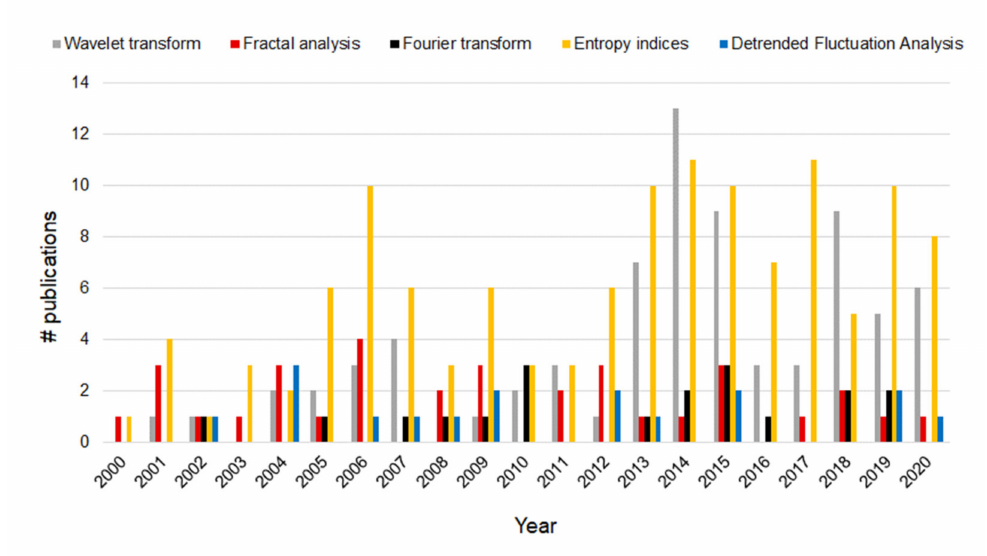
Figure 3. Annual distribution of the number of publications identified through the Web of Science database (for better readability, only the five most employed techniques in the period 2000–2020 are